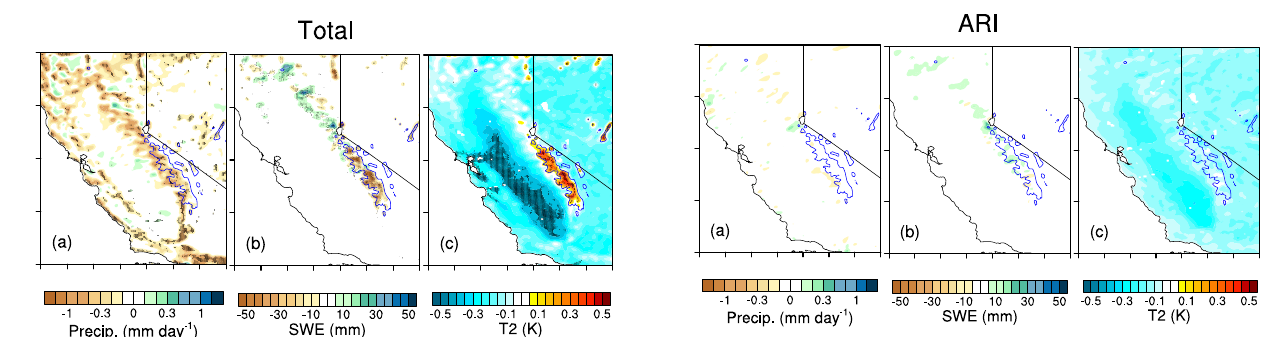
Figure 5. Total aerosol effects (CTRL – CLEAN) on spatial distri- butions of (a) precipitation (mmday − 1 ) , (b) SWE (mm), and (c) T2 (K). The dotted area denotes statistical significance above the 90% confidence level. Blue lines represent the mountaintops with eleva- tion ≥ 2.5km.